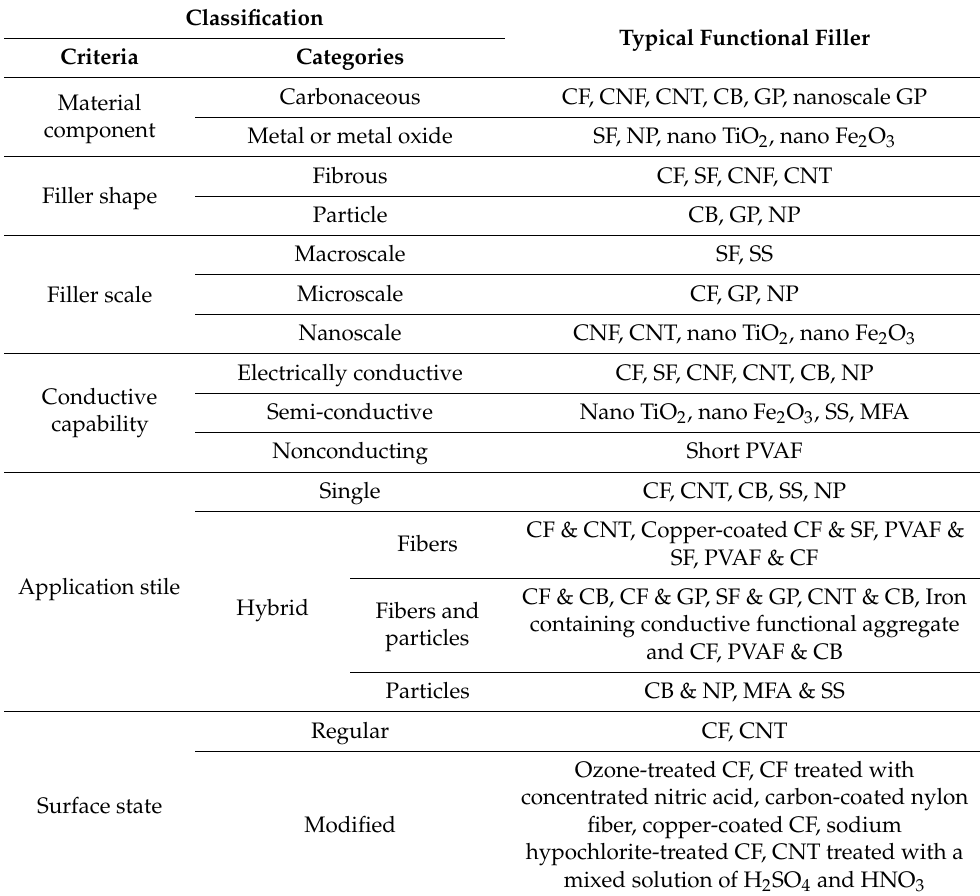
Table 1. Categories of functional fillers. Reproduced with permission from [17], Abdullah et al.,